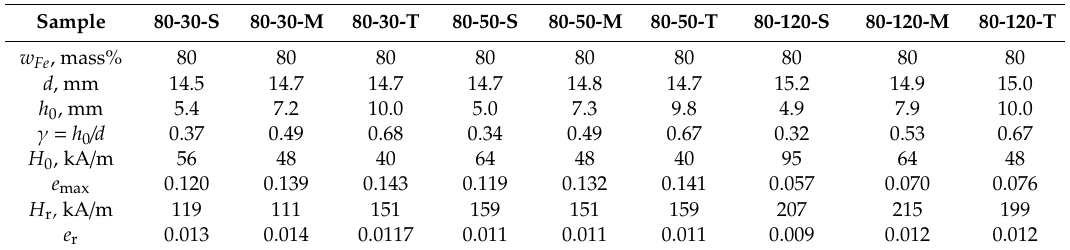
Table 3. Measurement results for MAE cylinders with 80 mass% of carbonyl iron.